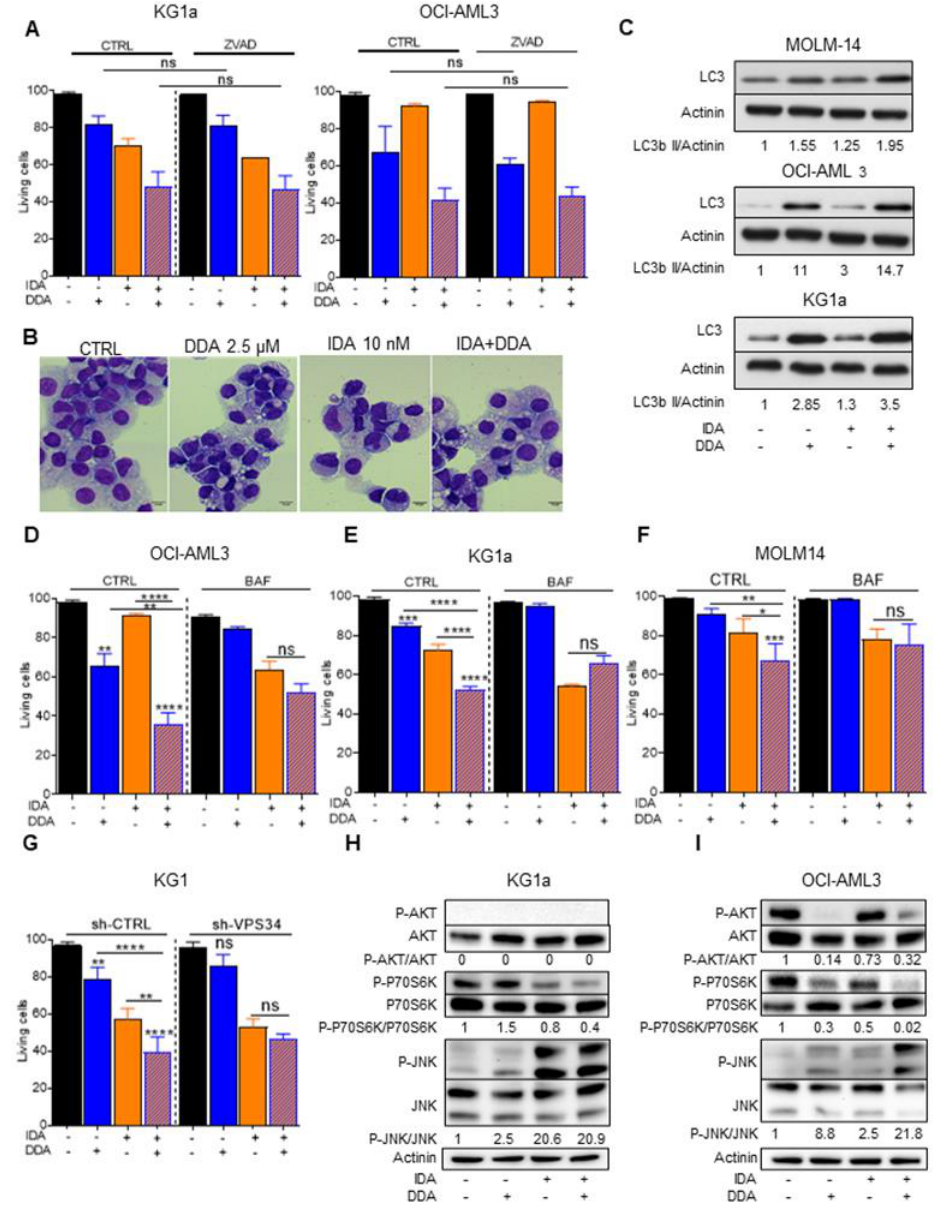
Figure 4. Implication of autophagy after DDA–idarubicin (IDA) treatment ( A ) Cell death measurement by Trypan Blue exclusion test after caspase inhibition on KG1a and OCI-AML3 cells treated for 48 h with DDA, IDA or both DDA and IDA in the presence or absence of ZVAD-FMK (40 µ M). Bars are mean ± SD of 3 independent experiments. ( B ) Representative images of primary AML cells stained with May Grumwald Giemsa after treatment with DDA (2.5 µ M) or IDA (10 nM) or both DDA and IDA (2.5 / 10 nM) or vehicle. ( C ) Western blot analysis of the expression of LC3-b II in three AML cell lines (MOLM-14, OCI-AML3 and KG1a) treated 5 h with vehicle, DDA, IDA or both IDA and DDA. ( D – F ) Cell death measurement by Trypan Blue exclusion test after autophagy inhibition on OCI-AM3, KG1a and MOLM14 cells treated for 48 h with DDA, IDA or both DDA and IDA in the presence or absence of bafilomycin A1. Bars are mean ± SD of 3 independent experiments. ( G ) Cell death measurement by Trypan Blue exclusion test after autophagy inhibition on KG1 shVPS34 treated for 48 h with DDA, IDA or both DDA and IDA. Bars are mean ± SD of 3 independent experiments. ( H , I ) Western blot analysis of the expression of p-AKT, AKT, pP70S6K, P70S6K, JNK and pJNK in two AML cell lines KG1a and OCI-AML3) treated for 5 h with vehicle, DDA, IDA or both IDA and DDA. Detailed information can be found at Figure S3. * p < 0.05, ** p < 0.01 and *** p < 0.001.